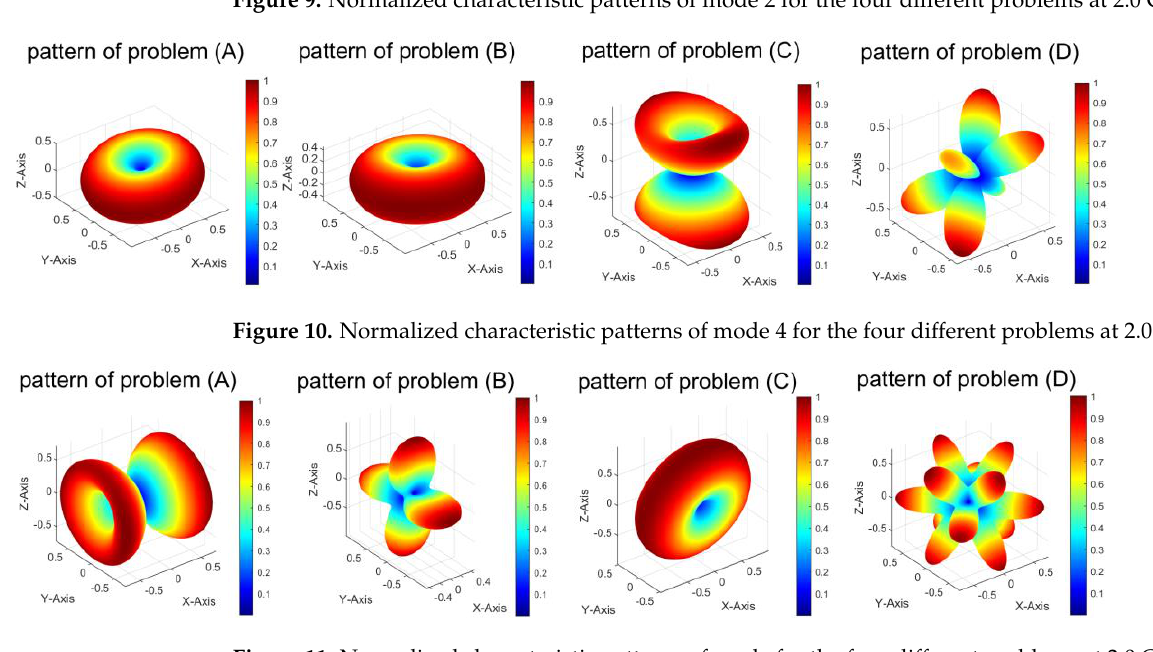
Figure 11. Normalized characteristic patterns of mode for the four different problems at 2.0 GHz.